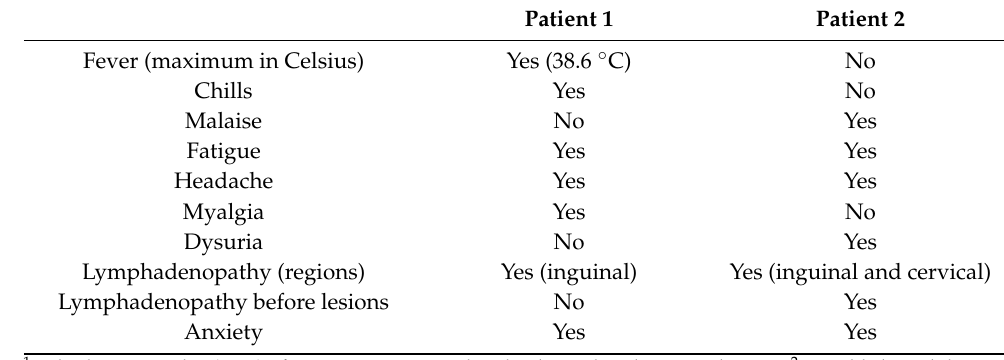
Table 1. Cont. Patient 1 Patient 2 Fever (maximum in Celsius) Yes (38.6 ◦ C) No Chills Yes No Malaise No Yes Fatigue Yes Yes Yes Yes